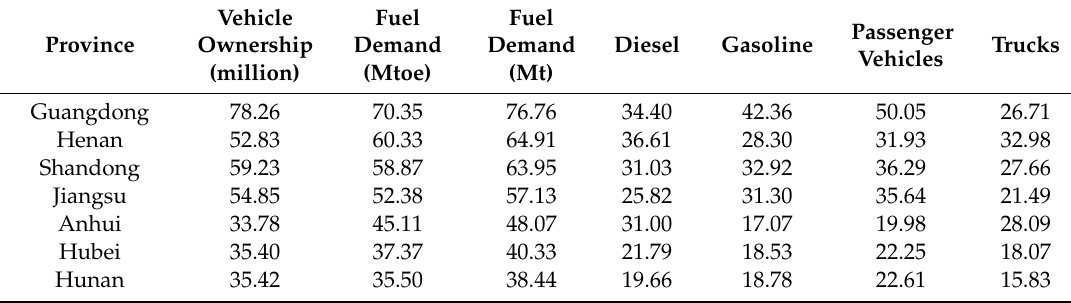
Table 5. Provincial projections of fuel consumption structure in